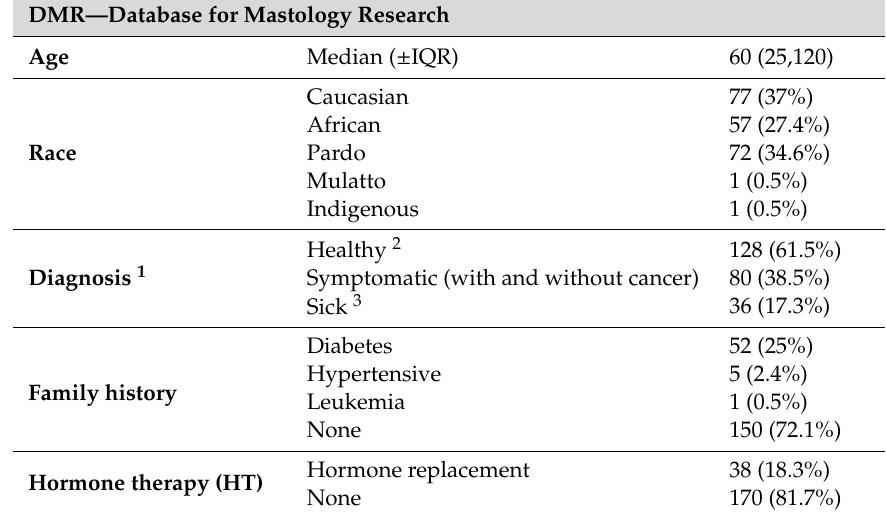
Table 1. Clinical information and demographics of the breast cancer screening database using thermal